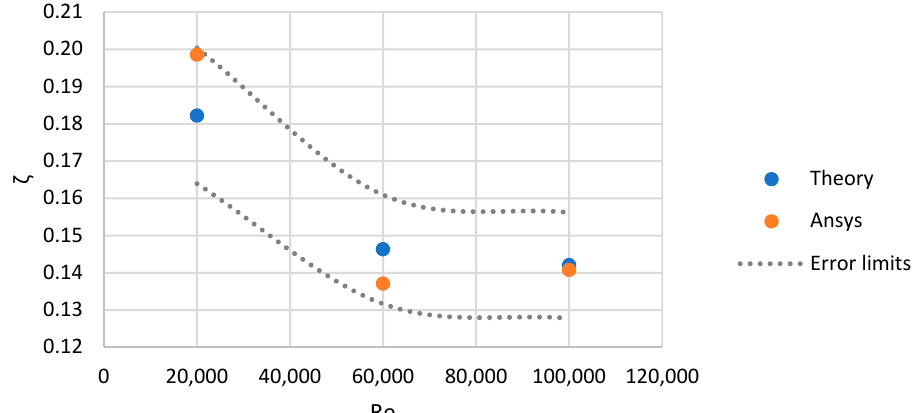
Figure 9. Graph of the coefficient of hydraulic resistance of the compound channel from the Reynolds number.